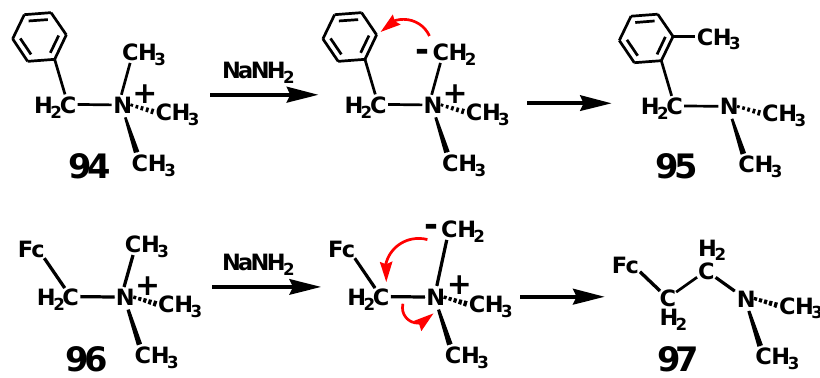
Scheme 30. Different Stevens rearrangements for analogous phenyl and ferrocenyl